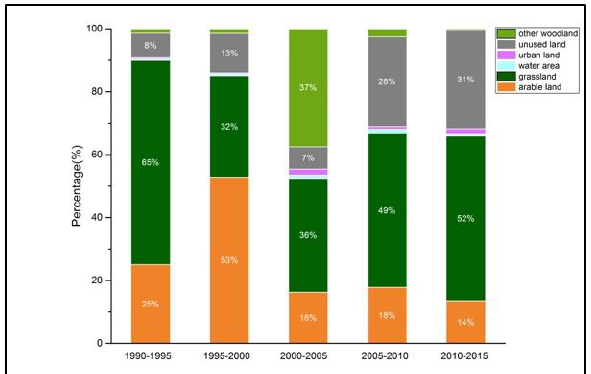
Figure 3. The whereabouts of forest loss From the perspective of municipal level, forest area of most